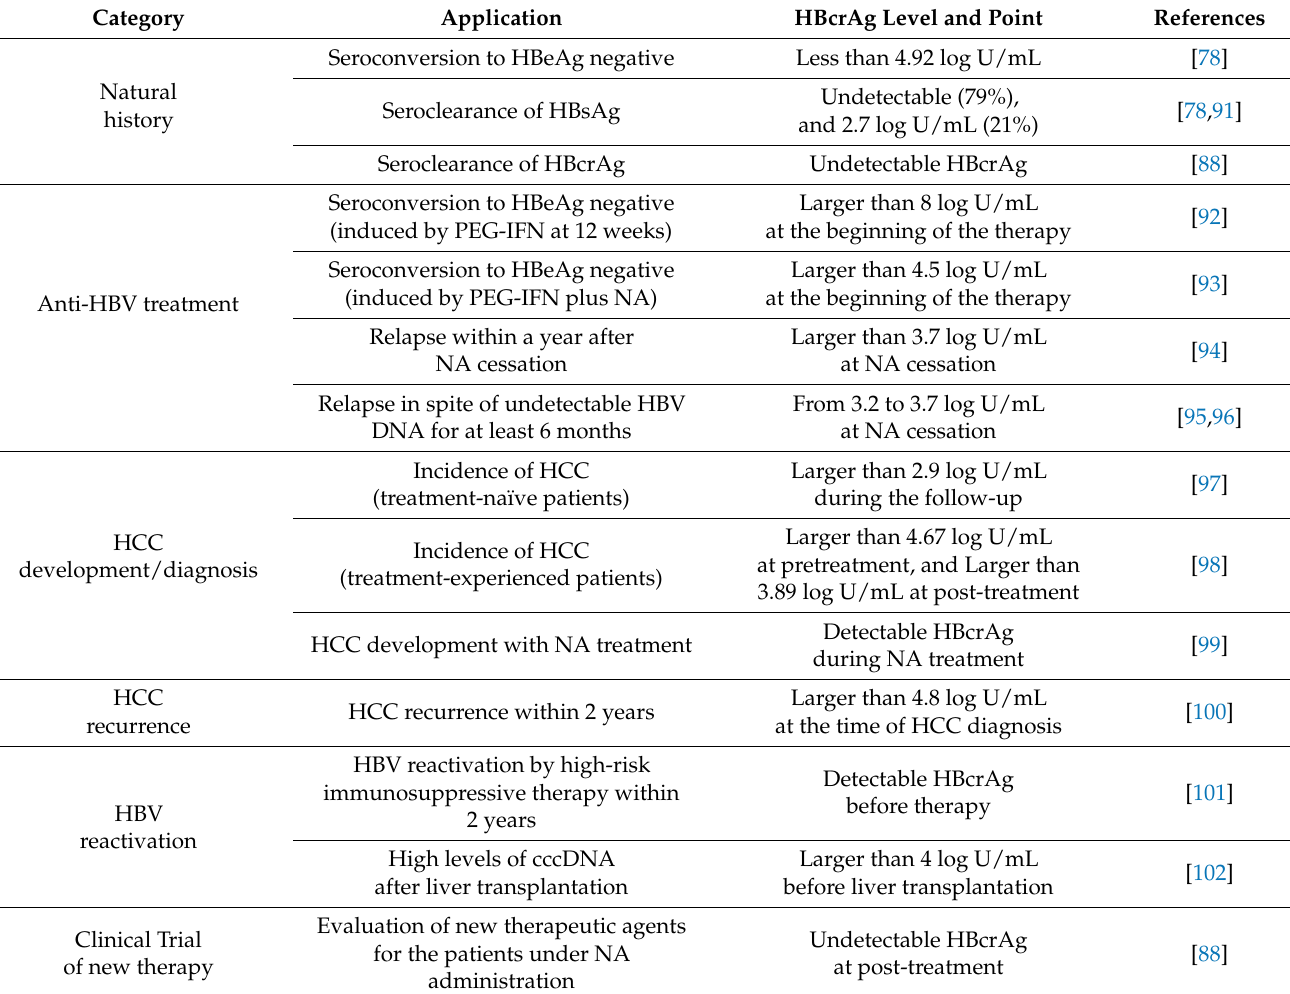
Table 3. Clinical applications of